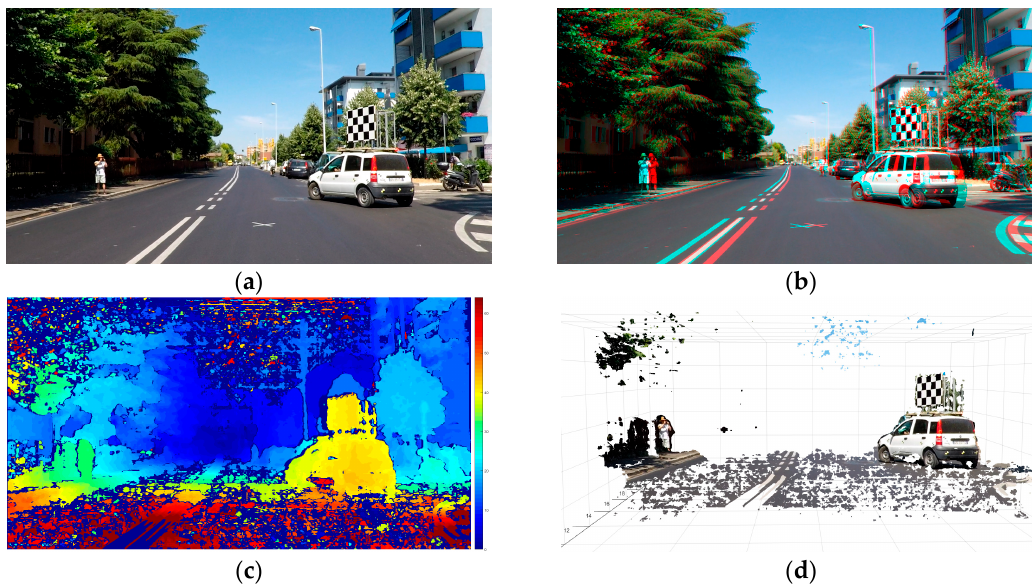
Figure 12 . Analysis of the pre-crash scene (id90–InSAFE). ( a ) Rectified left picture of the long range stereo camera sensor; ( b ) The 3D anaglyph composed by the stereo frame; ( c ) Disparity Map (0 to 64d); ( d ) 3D reconstruction available for download (Appendix B).